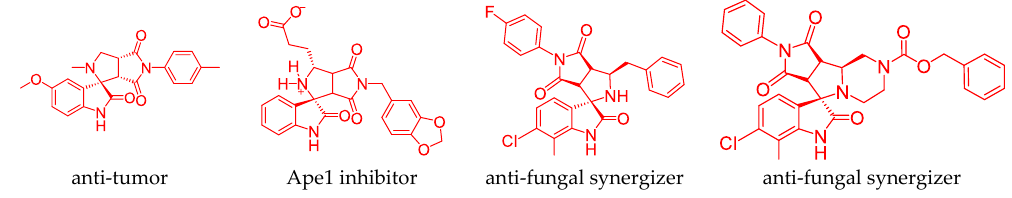
Figure 1. Representative bioactive succinimide-fused spiro[pyrrolidine-2,3 ′ -oxindoles].